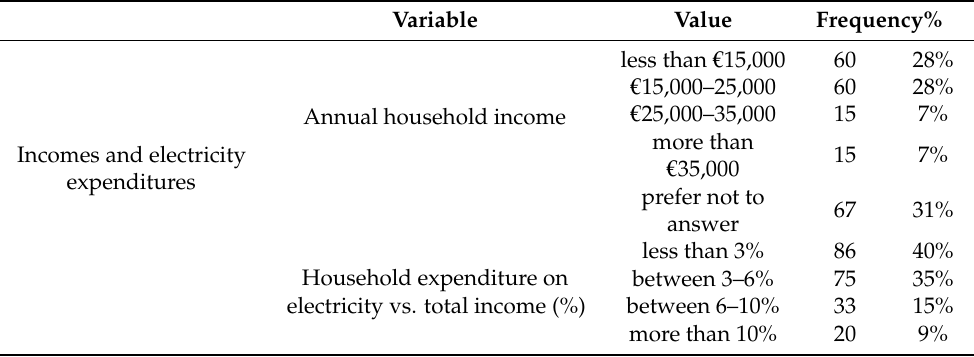
Table 3. Consumers’ incomes and electricity consumptions.